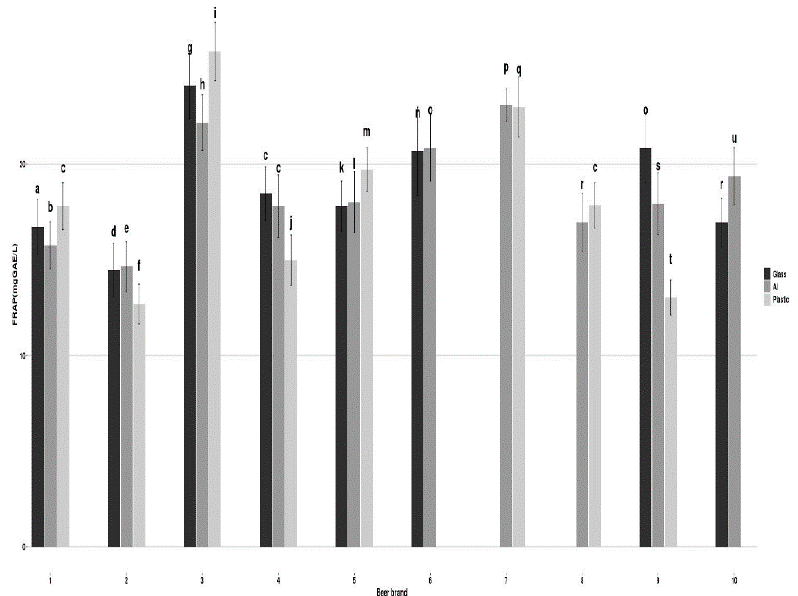
Figure 3. Ferric reducing power (mg GAE/L) for 10 beer brand and for three packing materials: glass, aluminium and plastic. Vertical bars above each column represent the standard deviation of triplicate determinations. Different letters indicate differences ( p < 0.05) between the materials.